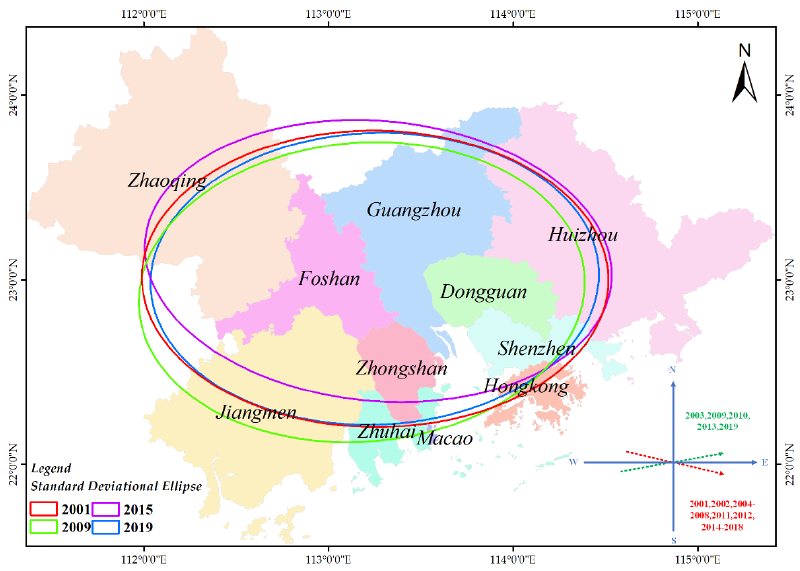
Figure 10. Spatial variation trend of precipitation in GBA from 2001 to 2019.